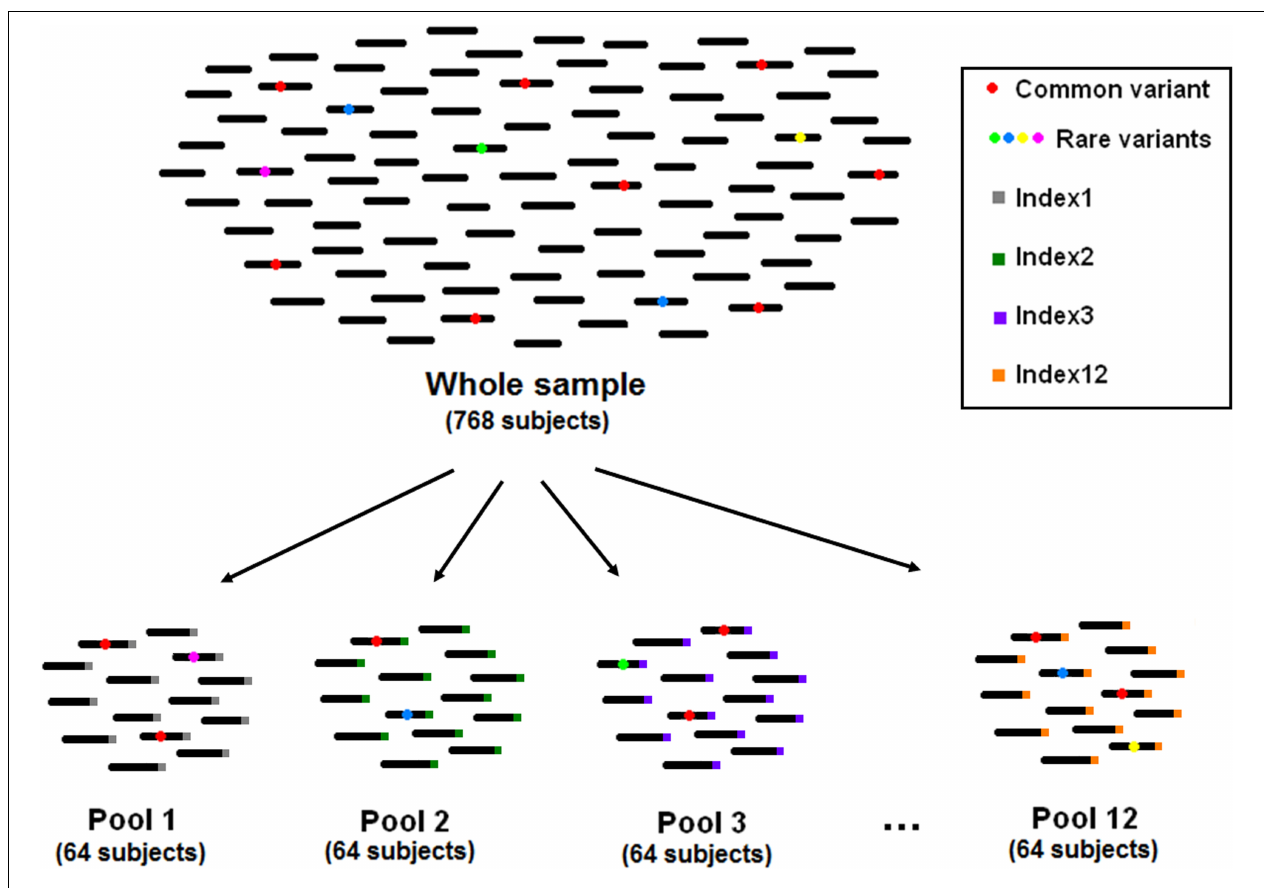
FIGURE 1 |The pooling strategy used by Marroni etal. (2011a).